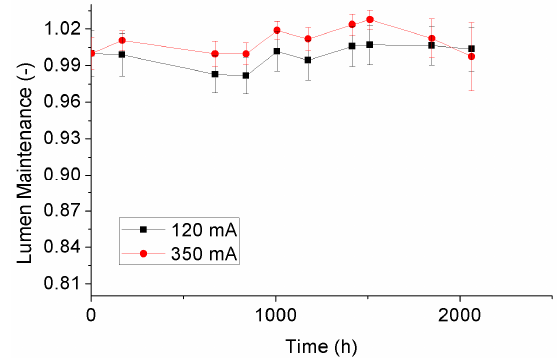
Figure 11. Lumen maintenance depreciation of the 4000 °K samples.